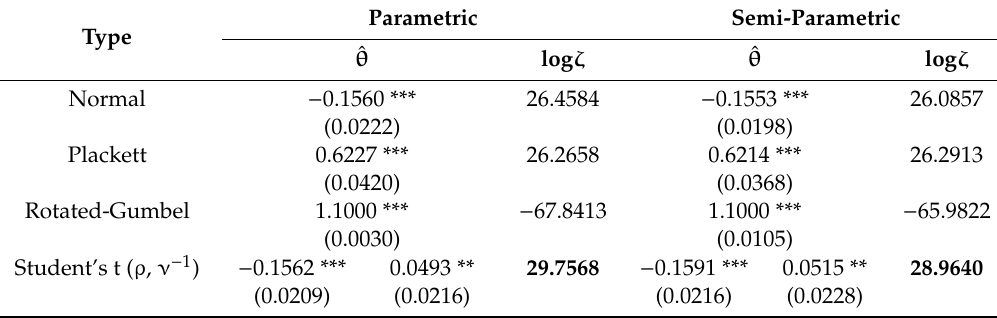
Table 9. Constant copula parameter estimation (Chinese Yuan—CNY).